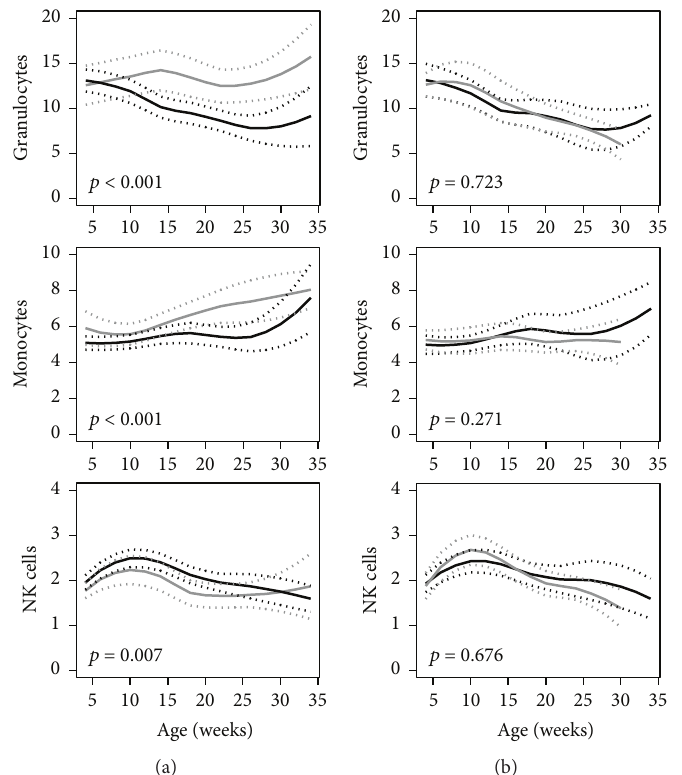
Figure 5: Trajectories of peripheral blood percentages of granulocytes, monocytes, and NK cells in (a) NOD mice (black line) versus NOR mice (gray line) and (b) NOD mice that developed diabetes (black line) versus NOD mice that were diabetes-free at age of 36 weeks (gray line). The unbroken lines represent 95% confidence intervals of the trajectories. 𝑝 values for the comparisons are shown in each